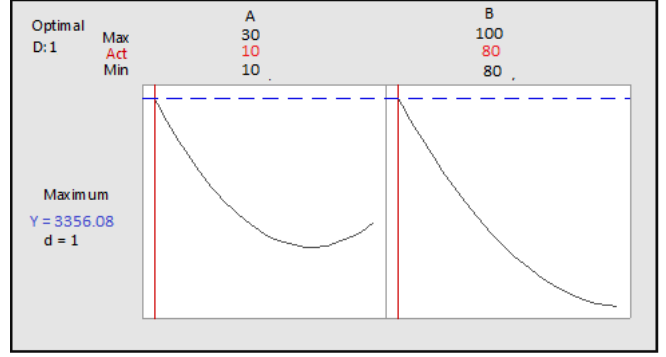
Figure 10. Optimization of two cooking time and temperature factors according to desirability; A: cooking time; B: cooking temperature.